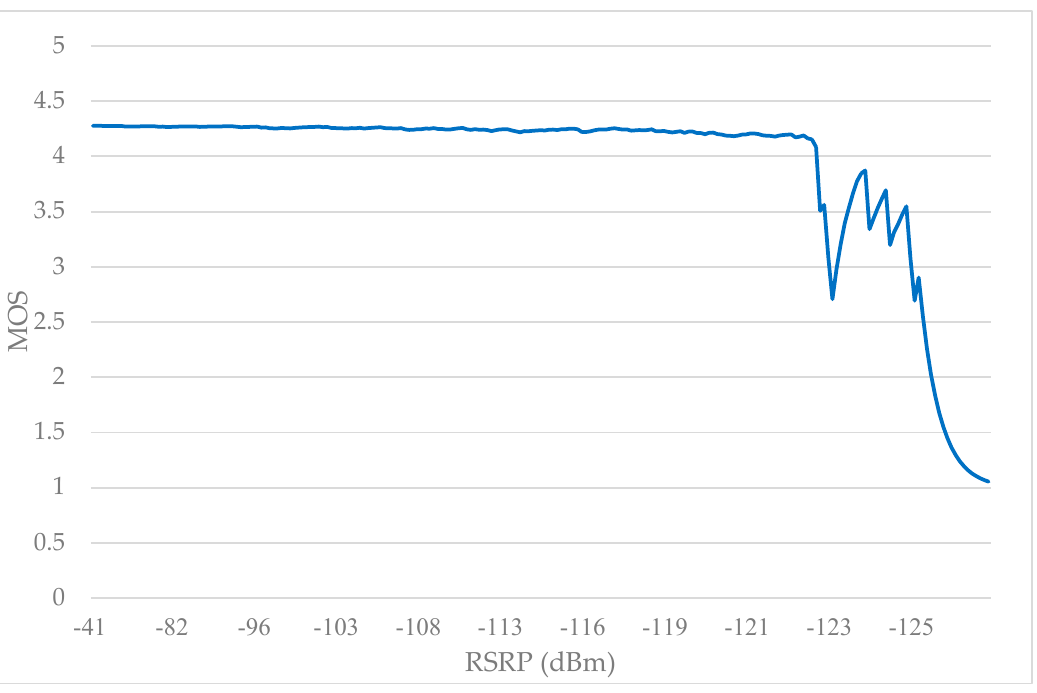
Figure 7. The relationship between MOS and RSRP for video conference service for UE.